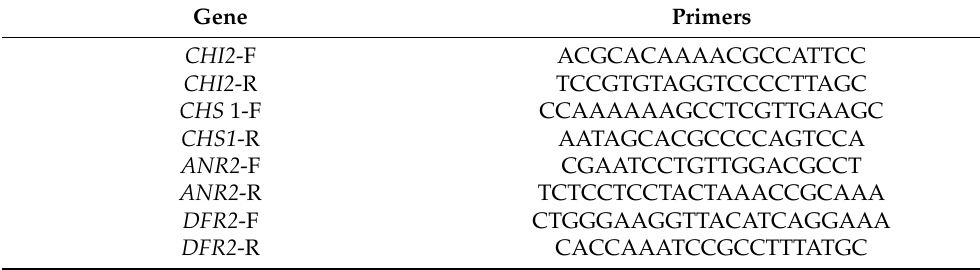
Table 1. Primers for